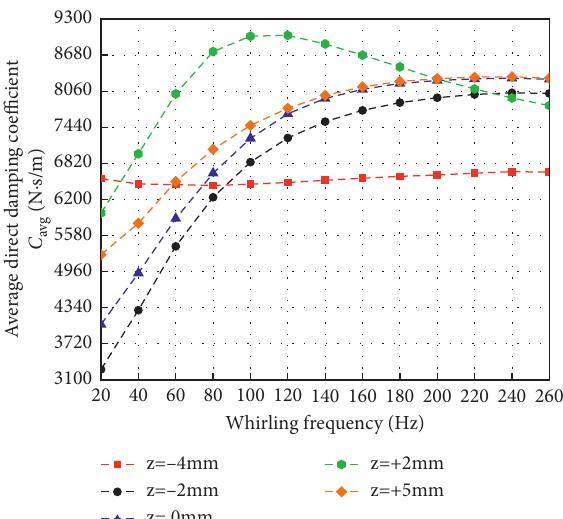
Figure 12: Direct complex dynamic stiffness coefficient vs. whirling frequency.